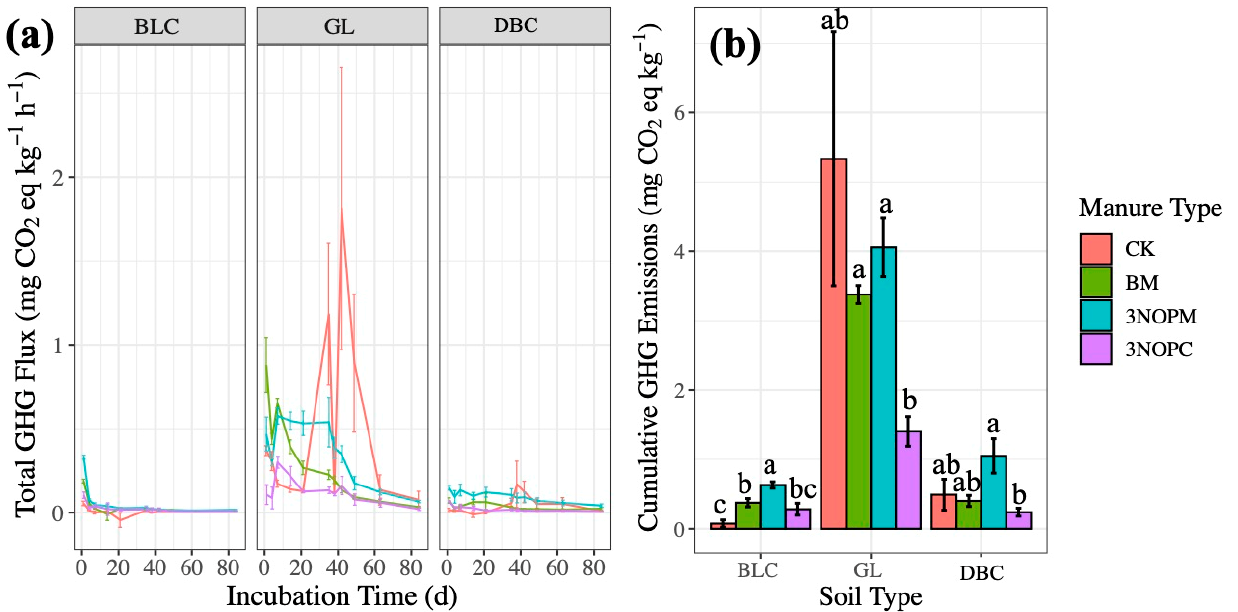
Figure 4. Effects of manure type on anthropogenic GHG emissions (N 2 O and CH 4 as CO 2 -equivalents) ( a ) over time by soil type and ( b ) cumulatively by soil type in a laboratory incubation experiment. Soil type: BLC, Black Chernozem; GL, Gray Luvisol; DBC, Dark Brown Chernozem. Manure type: CK, control with no amendments; BM, barley-based manure; 3-NOPM, manure from cows fed 3-NOP supplement; 3-NOPC, composted manure from cows fed 3-NOP supplements. Treatments that do not share the same letter are significantly different from each other. Error bars indicate standard errors of the means ( n = 4).